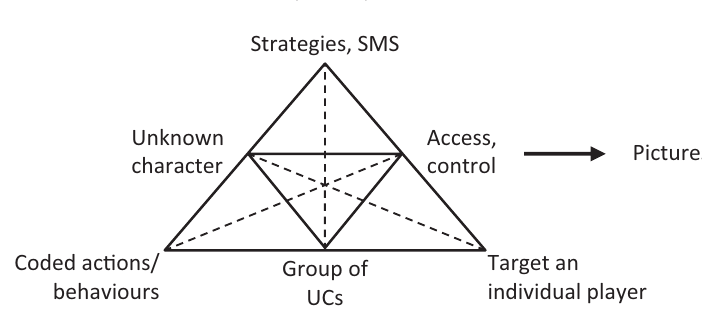
Figure 5. The activity of deception described as an activity